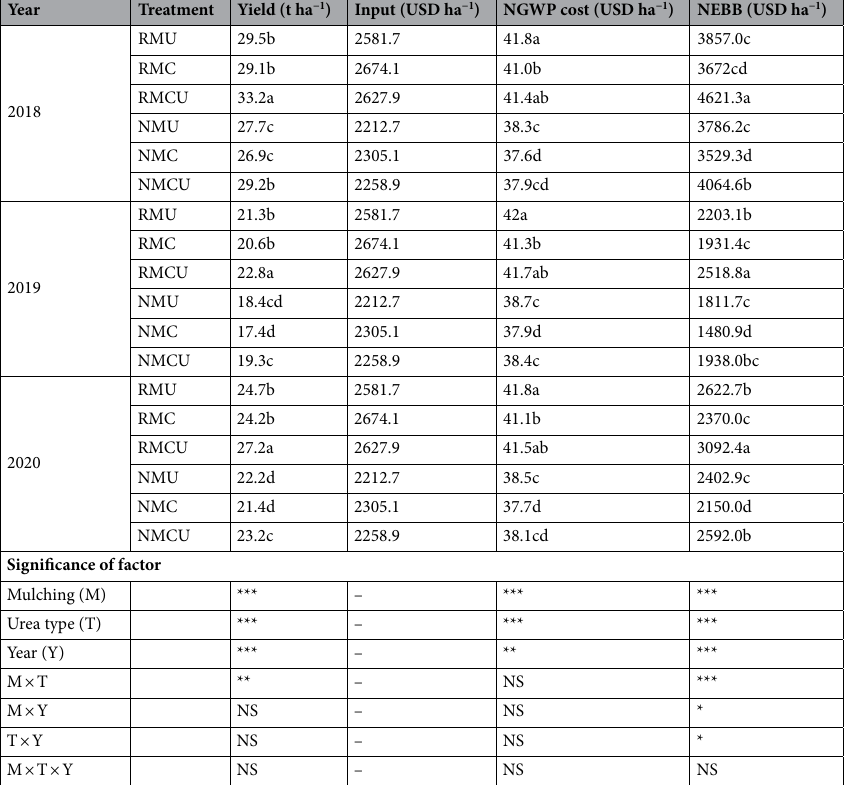
Table 4. Tuber yield and net ecosystem economic budget (NEEB) under different treatments in 2018–2020 growing seasons. RM plastic film mulching, NM no plastic film mulching, U conventional urea, C controlled- release urea, CU a mixture of equal amount of conventional urea and controlled-release urea at 1:1 ratio. Numbers followed by different letters in each column indicate significantly differences at α = 0.05 based on ANOVA test. The statistical significance is denoted by *P ≤ 0.05; **P ≤ 0.01; ***P ≤ 0.001, and NS not